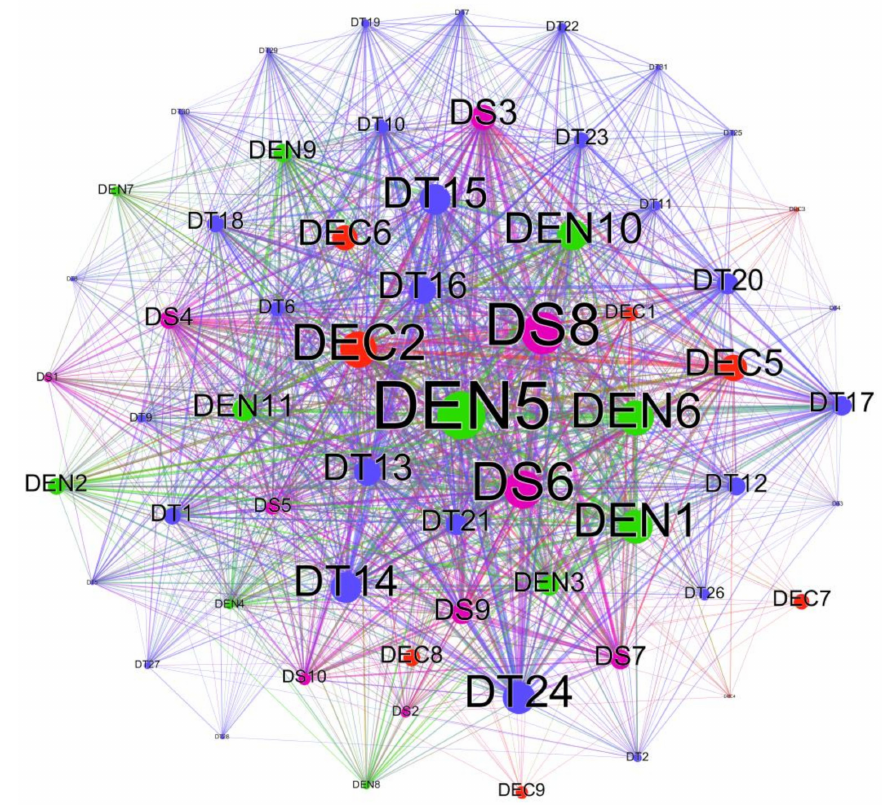
Figure 5. Design CSFs